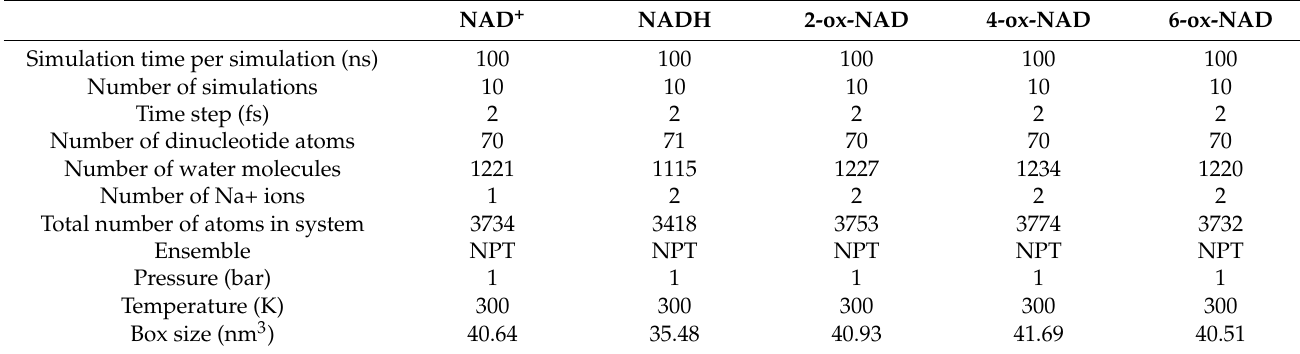
Table 2. Details of the MD